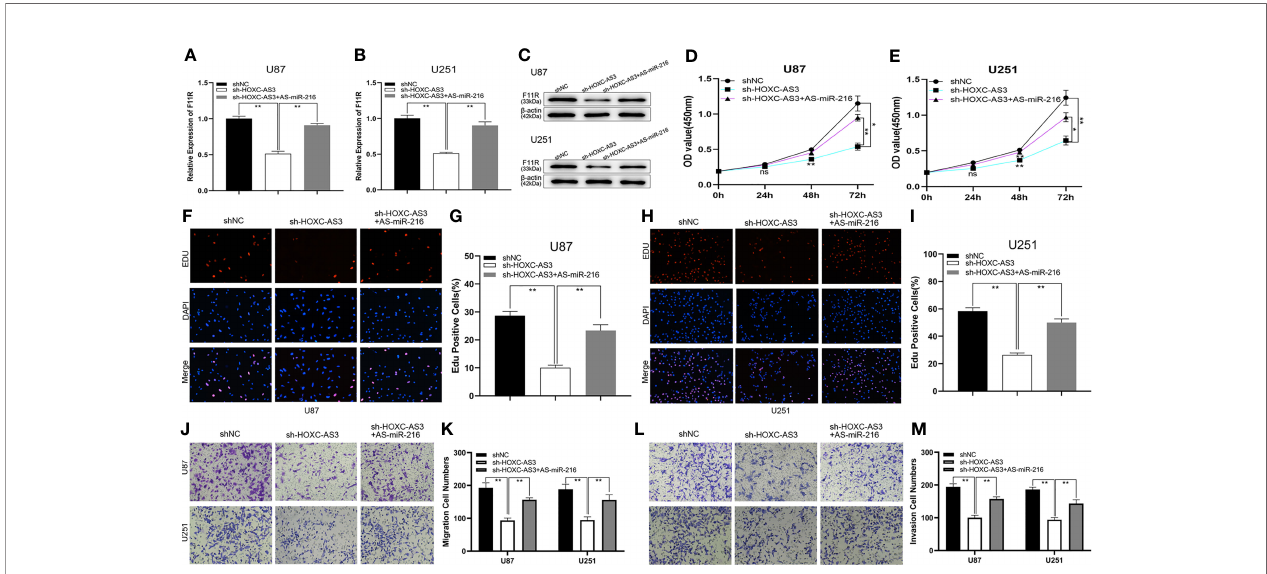
FIGURE 5 | HOXC-AS3 promoted the glioma malignancy phenotype by targeting the miR-216/F11R axis. (A – C) qRT-PCR and western blot were used to test the expression of F11R in U87 and U251 cells transfected with NC, sh-HOXC-AS3, or sh-HOXC-AS3 together with miR-216 inhibitors. (D, E) CCK-8 assay was used to test the proliferation of U87 and U251 cells transfected with NC, sh-HOXC-AS3, or sh-HOXC-AS3 together with miR-216 inhibitors. (F – I) EdU assay was used to test the proliferation of U87 and U251 cells transfected with NC, sh-HOXC-AS3, or sh-HOXC-AS3 together with miR-216 inhibitors. (J, K) Transwell assay was used to test the migration of U87 and U251 cells transfected with NC, sh-HOXC-AS3, or sh-HOXC-AS3 together with miR-216 inhibitors. (L, M) Transwell assay was used to test the invasion of U87 and U251 cells transfected with NC, sh-HOXC-AS3, or sh-HOXC-AS3 together with miR-216 inhibitors. *P < 0.05, **P < 0.01. One- way ANOVA and post hoc test for (A, B, G, I, K, M) . Two-way ANOVA and post hoc test for (D, E) .